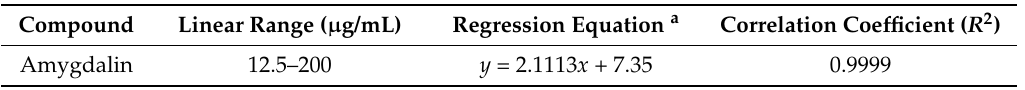
Table 2. Content of amygdalin in the apricot kernel extract.